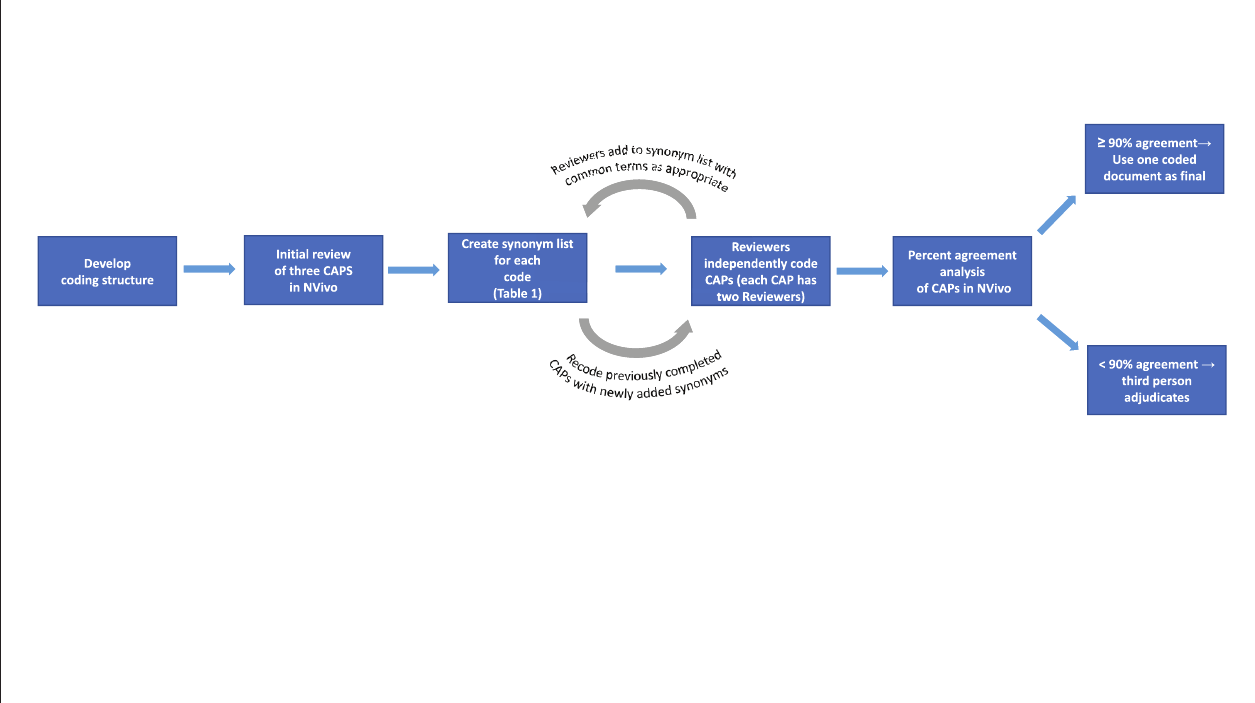
only slightly lower percentages, ∼ 1.1% for each city. The cities with the smallest percentages were Amsterdam (0.01%) and London